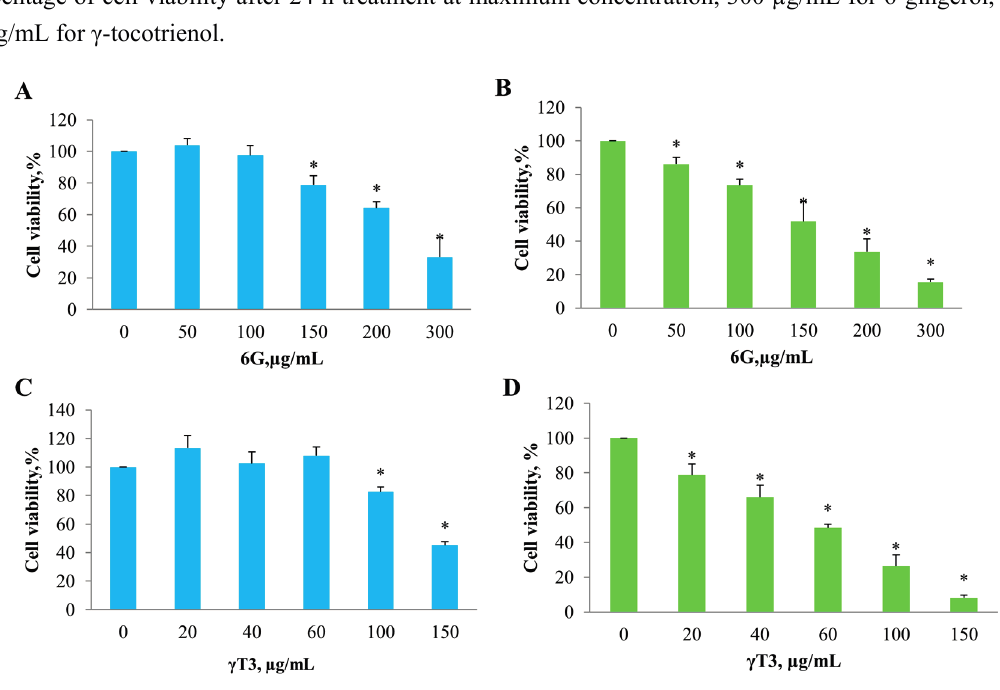
Figure 1. Cell viability assay of individual 6G and γ -T3 of both untreated and treated HT 29 ( A , C ) and SW 837 ( B , D ) cells after 24 h treatment. HT 29 and SW 837 cells were treated with 6G (0, 50, 100, 150, 200, and 300 µg/mL) and γ -T3 (0, 20, 40, 60,100, 150 µg/mL). Cell viability was observed using ELISA microplate reader at 405nm. Values are expressed as mean ± SEM from three independent experiments in triplicates ( n = 3). * significant when compared with untreated cells ( p <